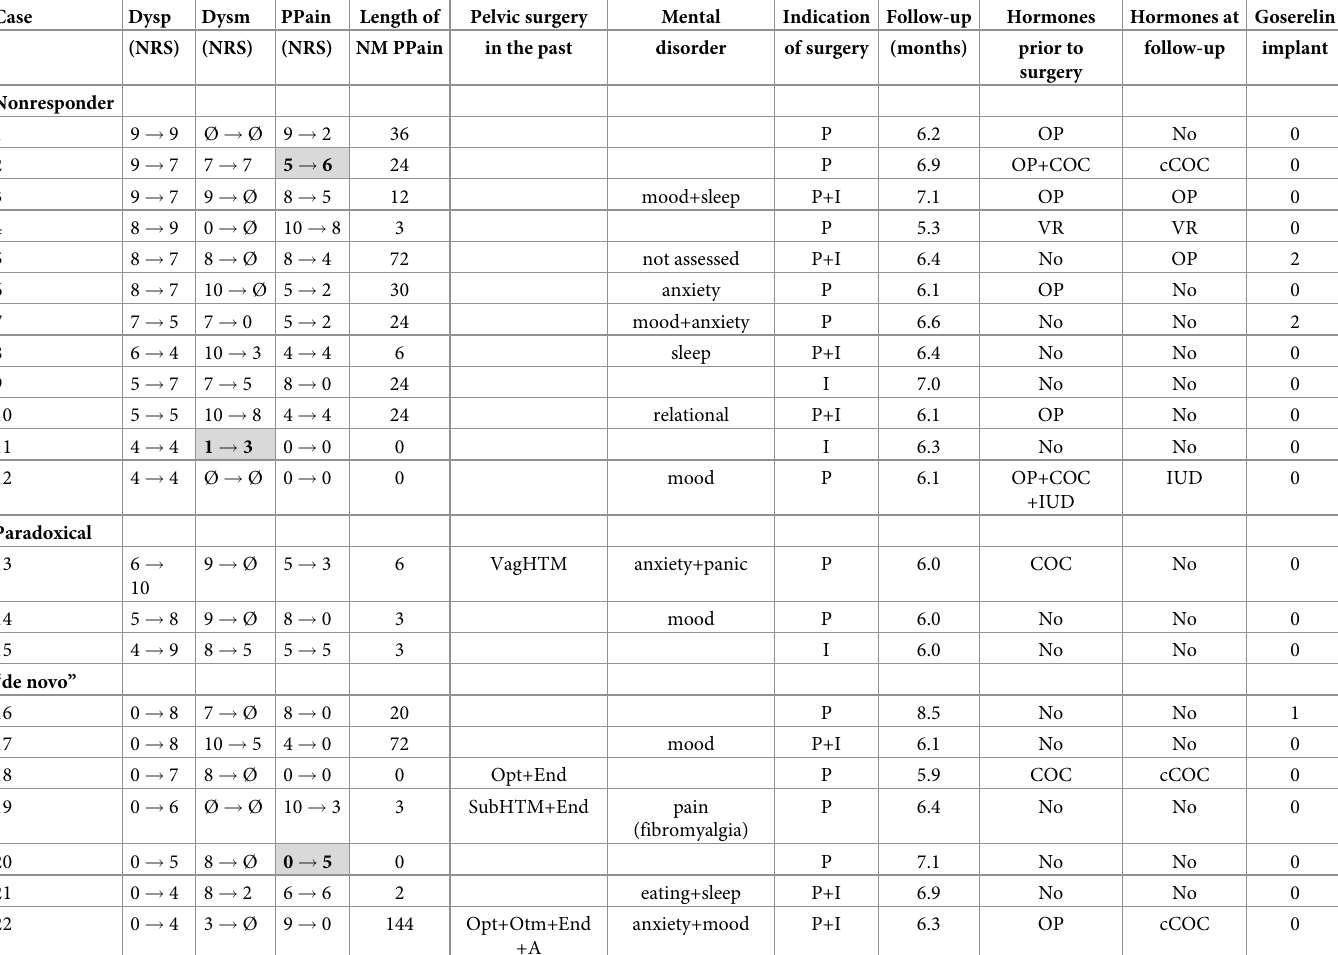
Table 3. Possible confounders in assessing pain response to surgery and the changes in self-reported endometriosis-related symptoms assessed prior to surgery and at follow-up in the 22 women who were not considered responders for deep